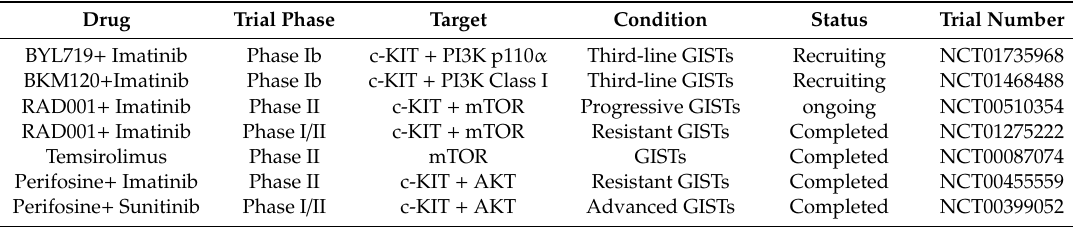
Table 3. Clinical trials in GISTs with therapeutic targets in the PI3K / AKT / mTOR